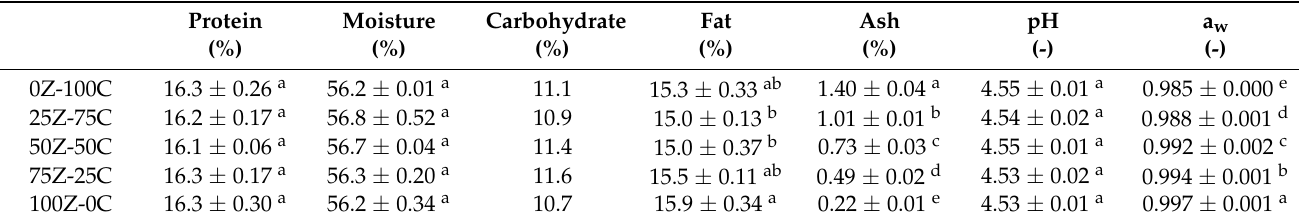
Table 2. Composition of plant-based cheese alternative samples.